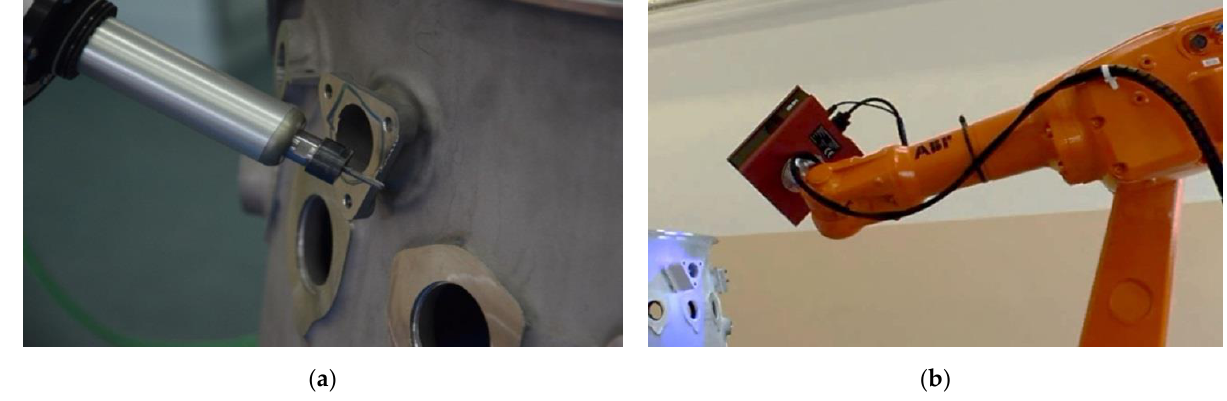
Figure 6. ( a ) View of deburring process; ( b ) measurement with a 3D scanner.